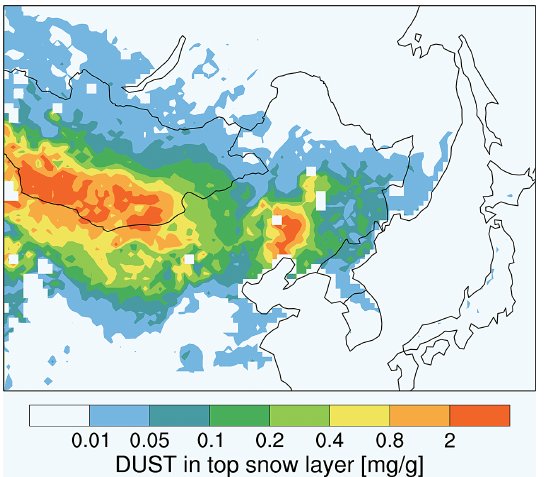
Figure 9. Spatial distribution of dust mass concentration in the top snow layer from the WRF-Chem simulations over North China in January–February 2010.